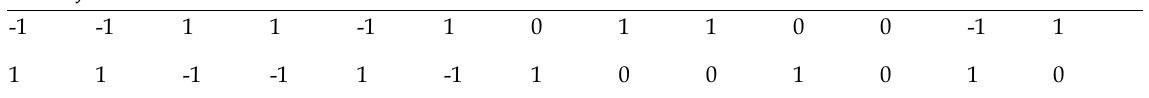
Table 4. Example of coded choice set